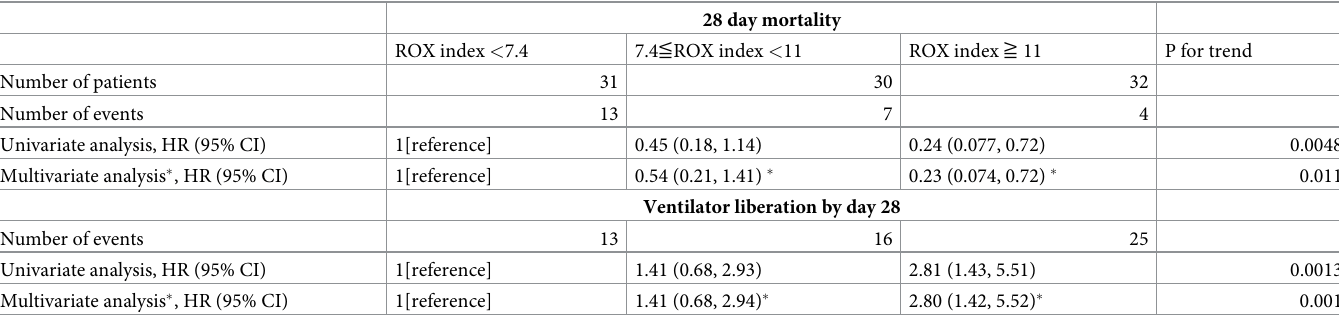
Table 2. Correlation of the ROX index with